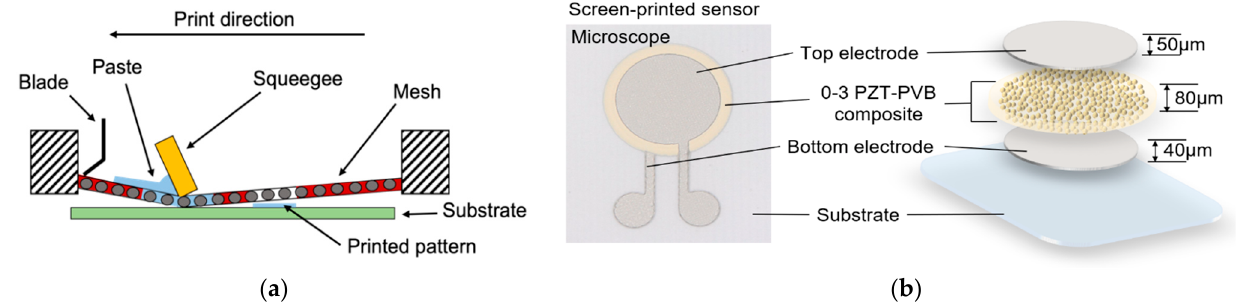
Figure 2. ( a ) Schematic of the screen ‐ printing process; ( b ) microscope image of the screen ‐ printed sensor (left) and schematic of sensor’s structure (right).